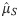
Mean dominance times in stable state as a function of the successive state.In the empirical data set, the mean dominance time before a state transition SU is shorter than the mean dominance time before SS (A). This observation can be reproduced in the HBMi (C), while the expected dominance time in the HMM (B) is equally long for intervals with and without transition, i.e., independent from transition between states. In the empirical data set [10], the state transitions were estimated using the Viterbi paths [34]. Analogous results were obtained using a fixed threshold. For the HBMi, the expected dominance times were derived from the HBMi parameters according to Eq (15) in the Materials and methods. In the HMM, expected dominance times correspond to μ^S.